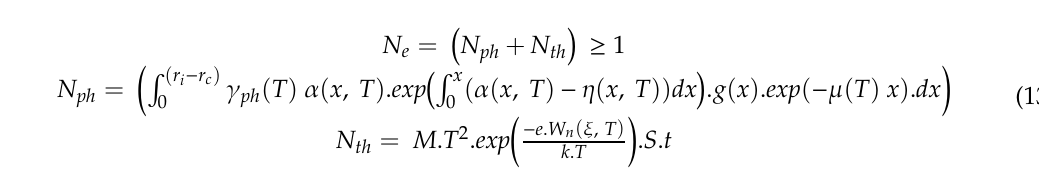
Figure 4. Development of an avalanche.